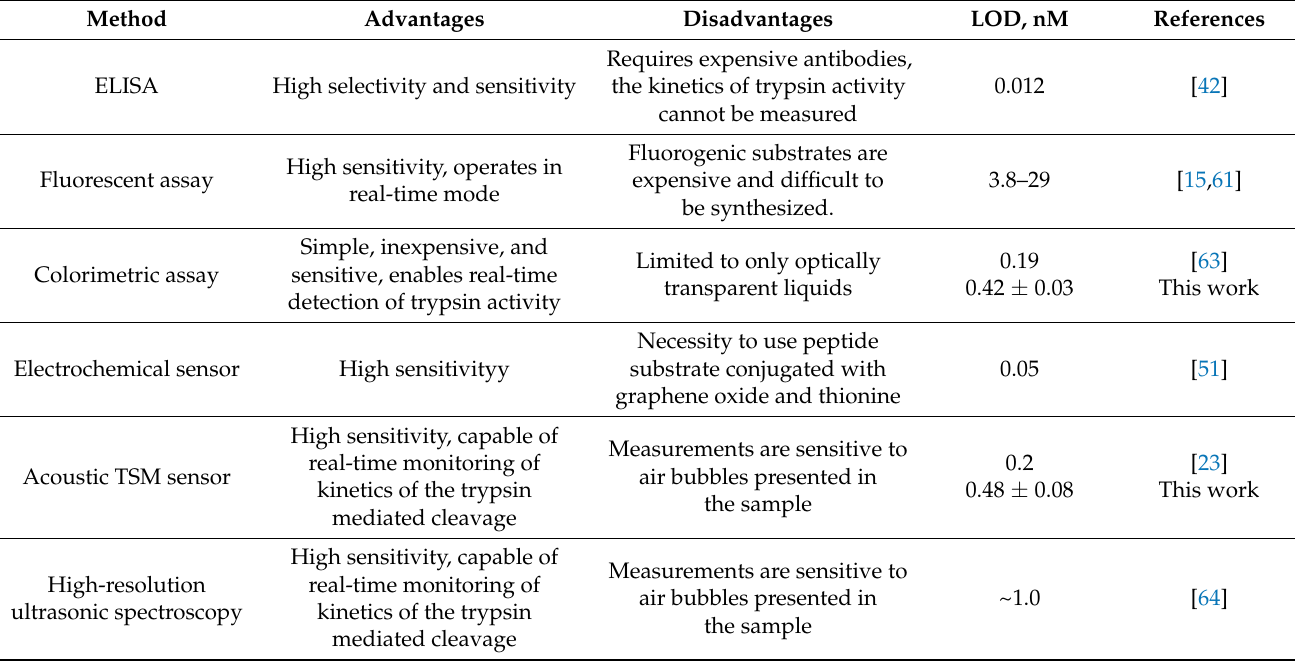
Table 2. Comparison of the most used analytical methods for trypsin